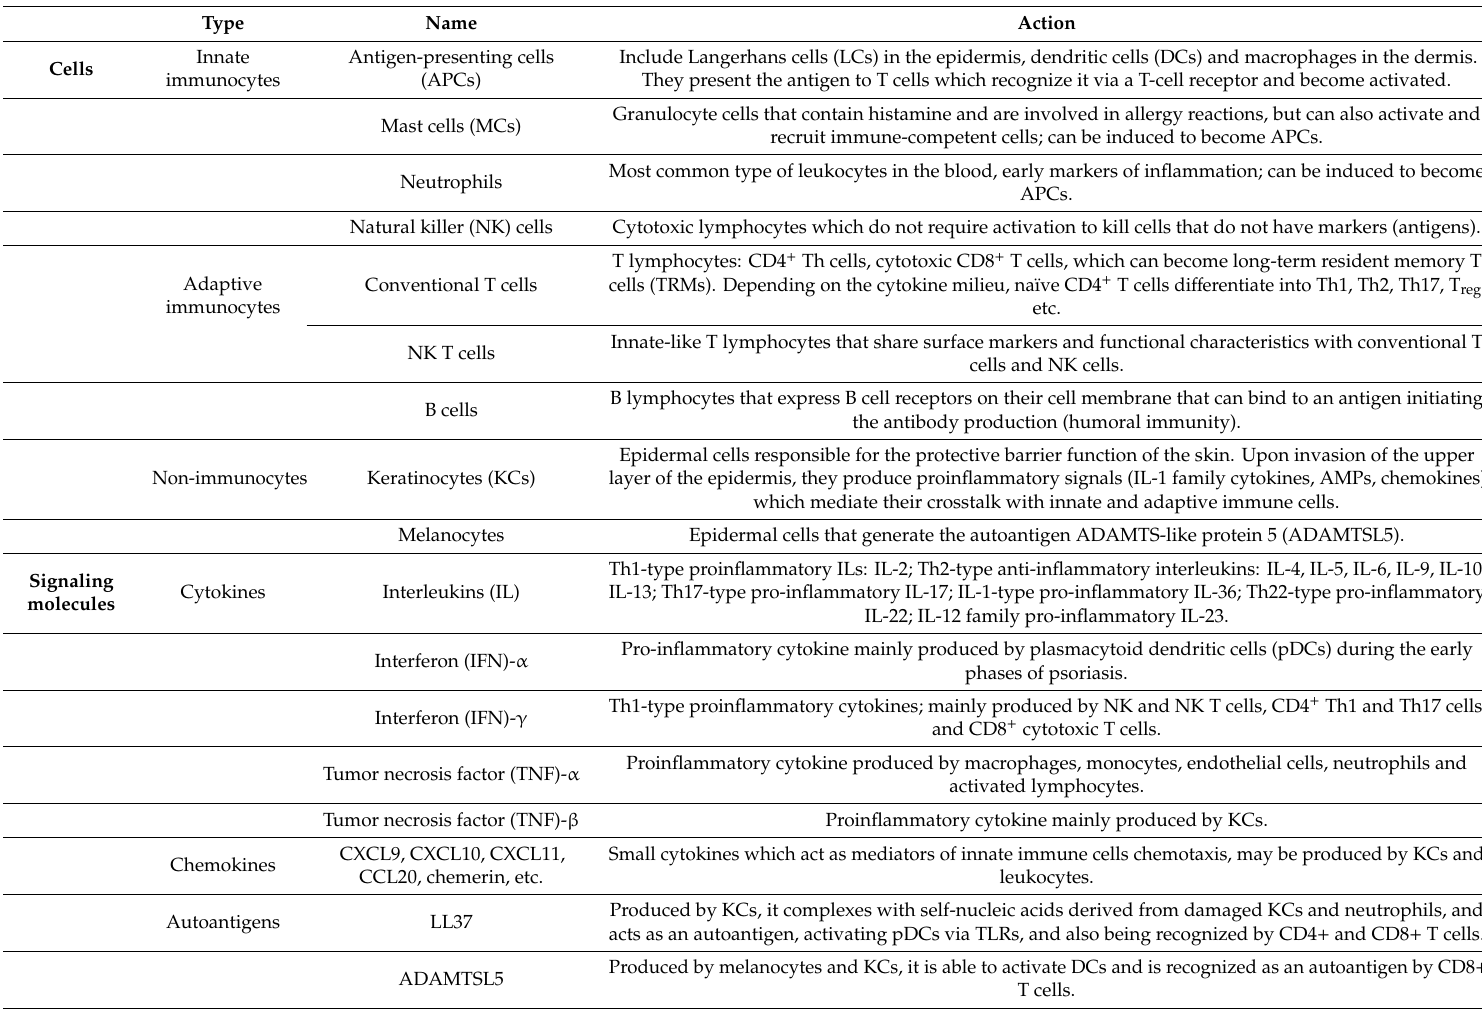
Table 2. Cells and signaling molecules that play a central role on the pathogenesis of